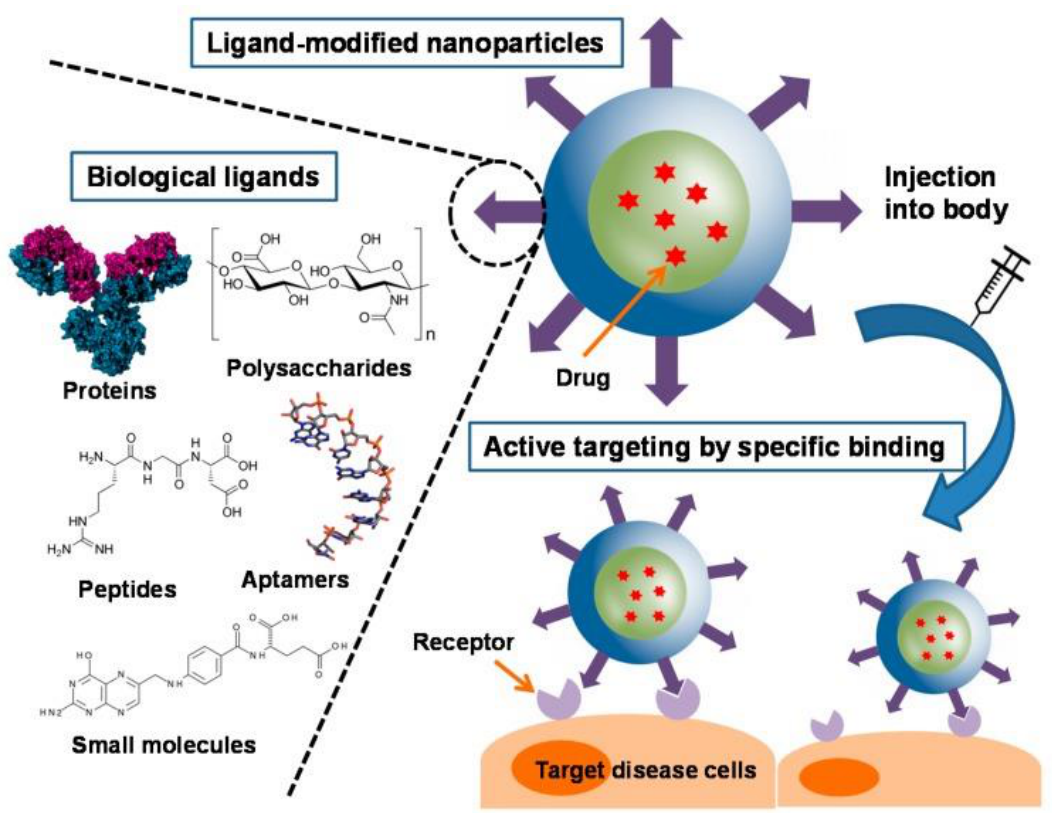
Figure 20. Illustration of biological ligands for active targeting of nanoparticle drug carriers. Taken from ref. [162], copyright 2019, with permission from MDPI.